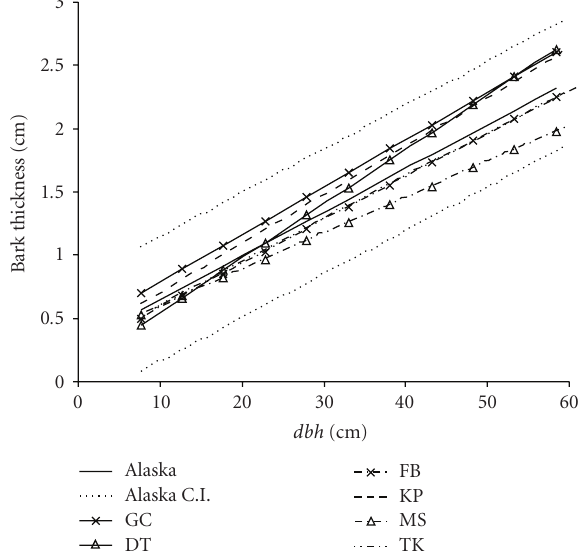
Figure 3: Predicted bark thickness (cm) from the Alaska model (Alaska) with 90% confidence interval (Alaska C.I.), and from the models fit for the six individual areas: Glennallen/Copper River Valley (GC), Delta (DT), Fairbanks (FB), Kenai Peninsula (KP), Mat-Su Valley (MS), and Tok